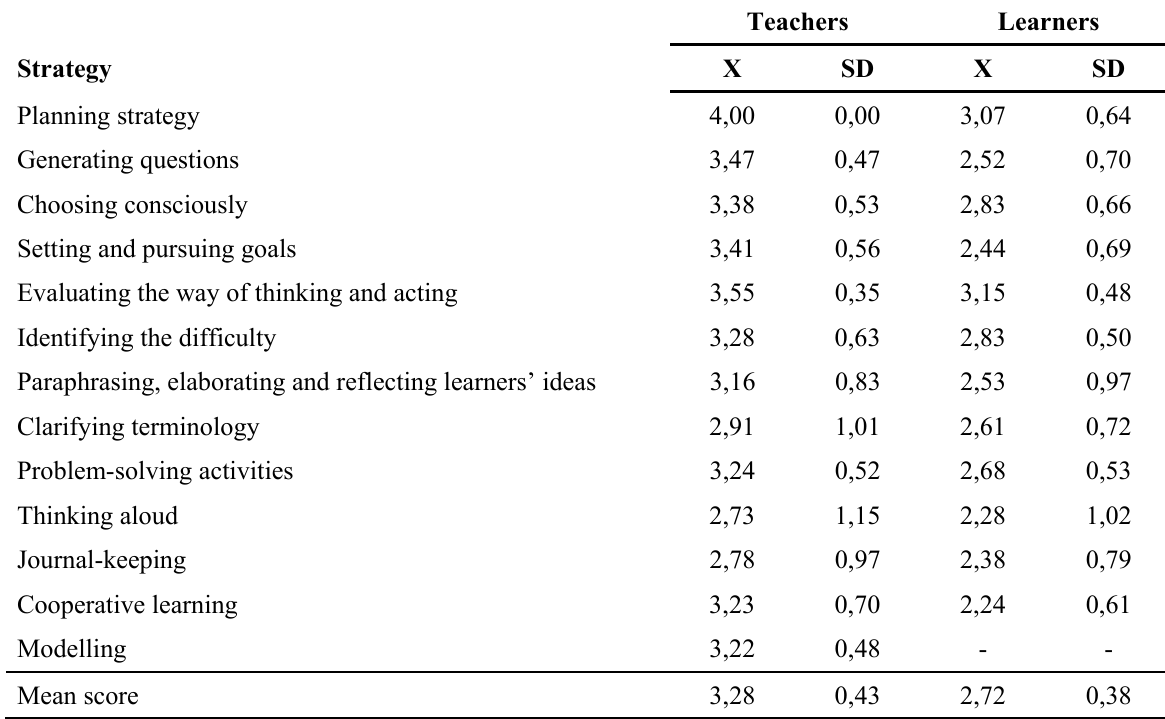
Table 3 : The extent to which metacognitive strategies are implemented by teachers and learner s Teachers